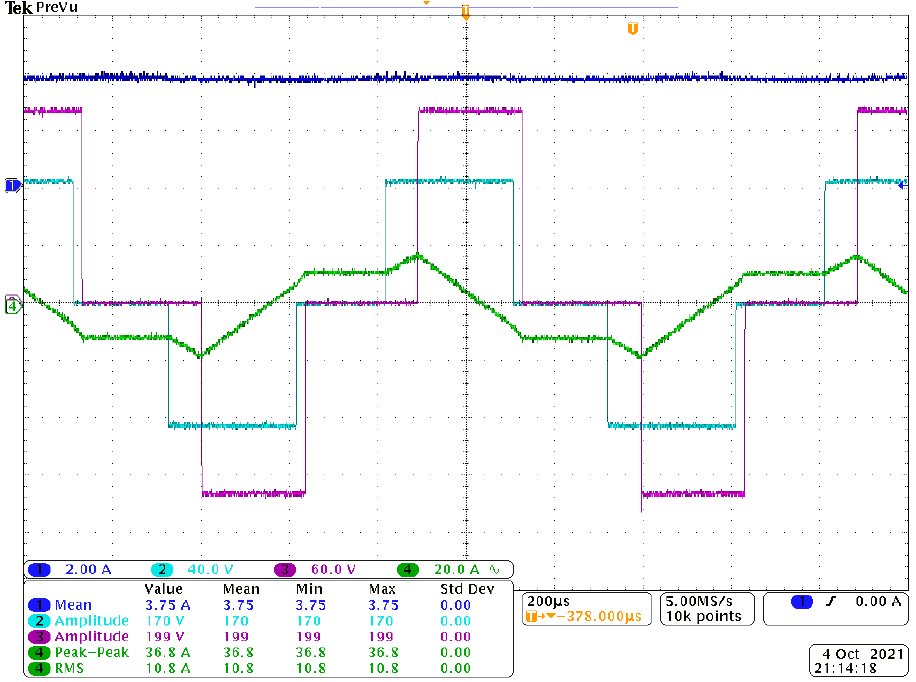
Figure 19. DAB operation under the TPS method at medium